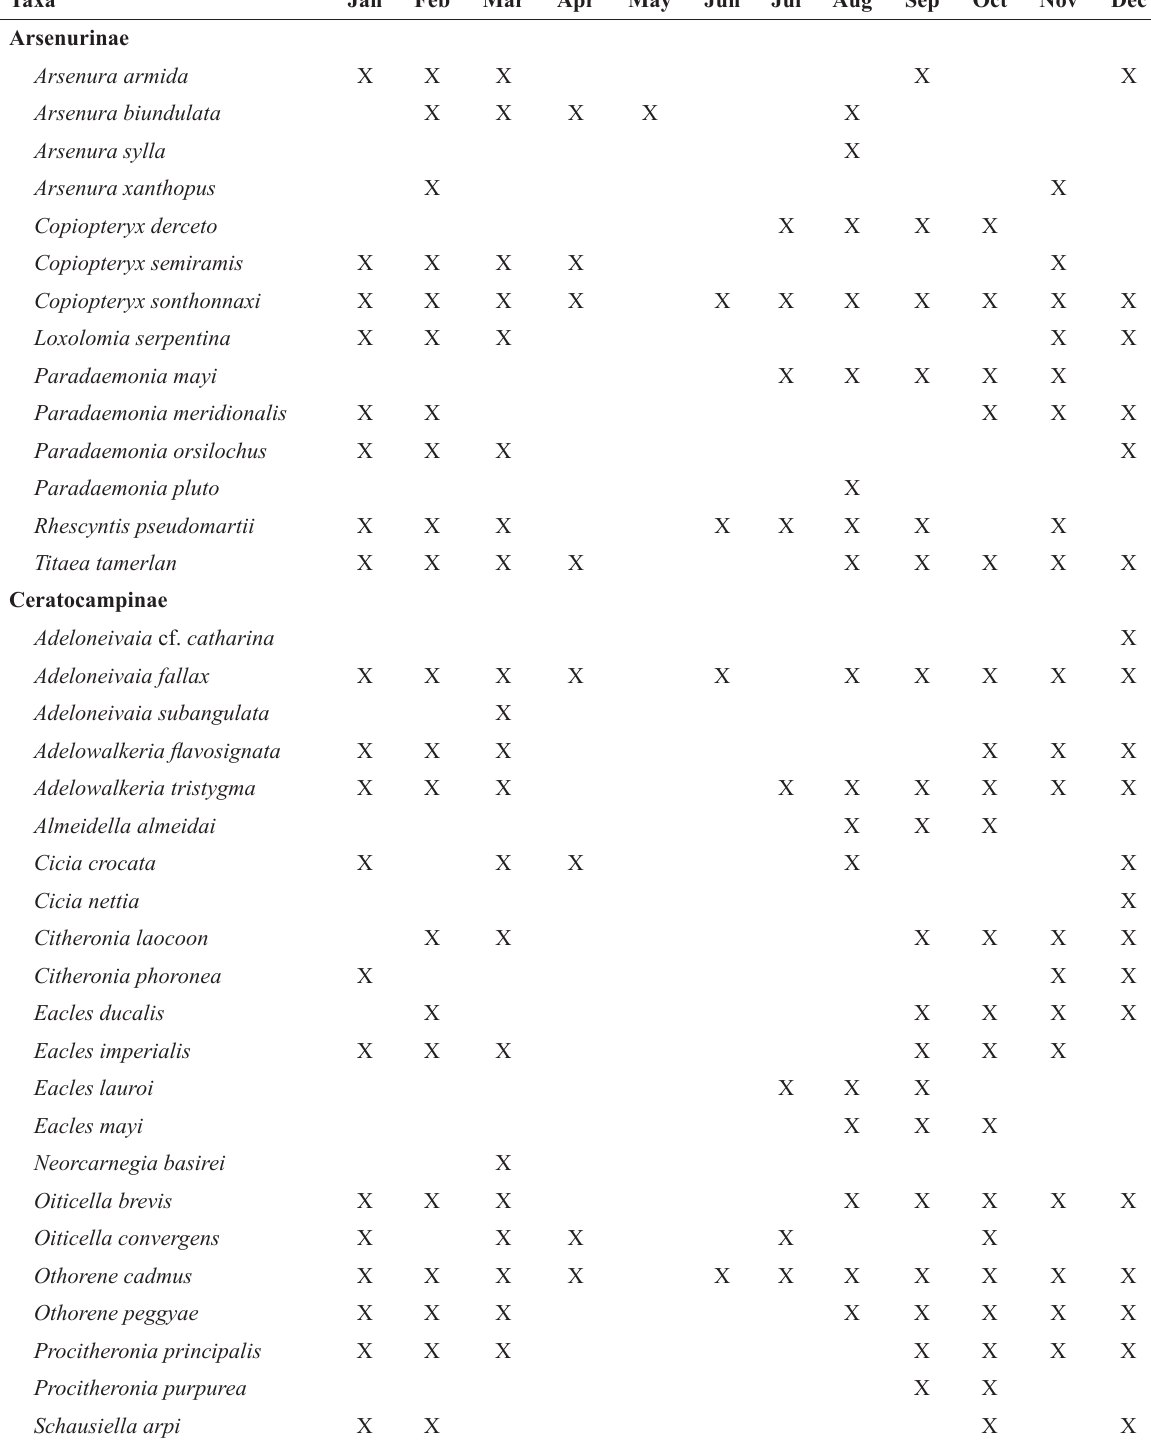
Phenology of the species of Saturniidae recorded between 1942 and 2013 from the Boraceia Biological Station, Salesópolis, São Paulo, Brazil (based on the material deposited in the